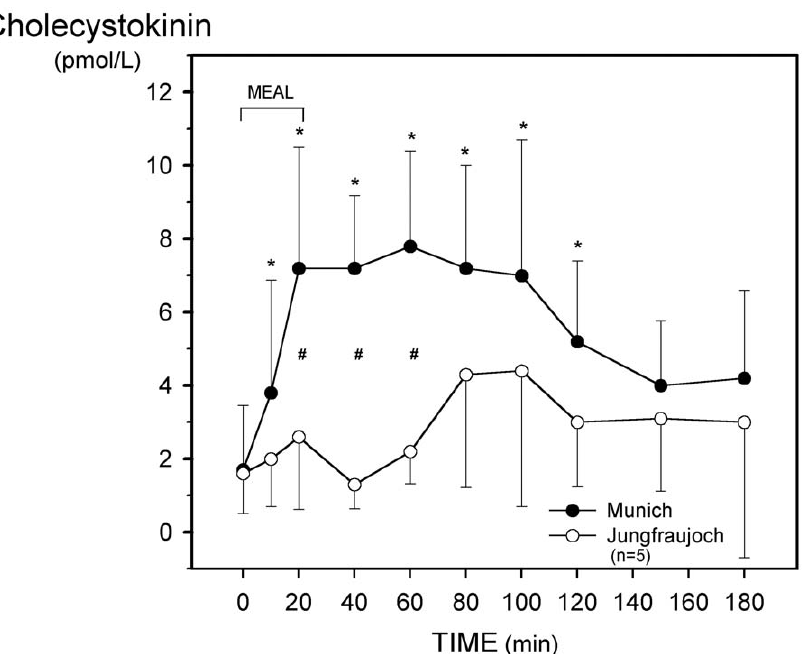
Figure 1. Effect of acute exposure to high altitude (Munich, 490 m, to Jungfraujoch, 3454 m) on postprandial plasma levels of cholecystokinin (CCK). Asterisks (*) indicate a significant increase (p , 0.03) as compared with the preprandial values at 0 min and crosses ( # ) mean a significant (p , 0.03) difference between the respective values at the two sea levels. the areas under the concentration curves in order to compare the ‘‘total’’ peptide release. The integrated incremental responses ( D ) were obtained by subtraction of the preprandial levels. Integrated incremental responses at Jungfraujoch and at Munich were compared and analyzed with the Wilcoxon test for paired data.